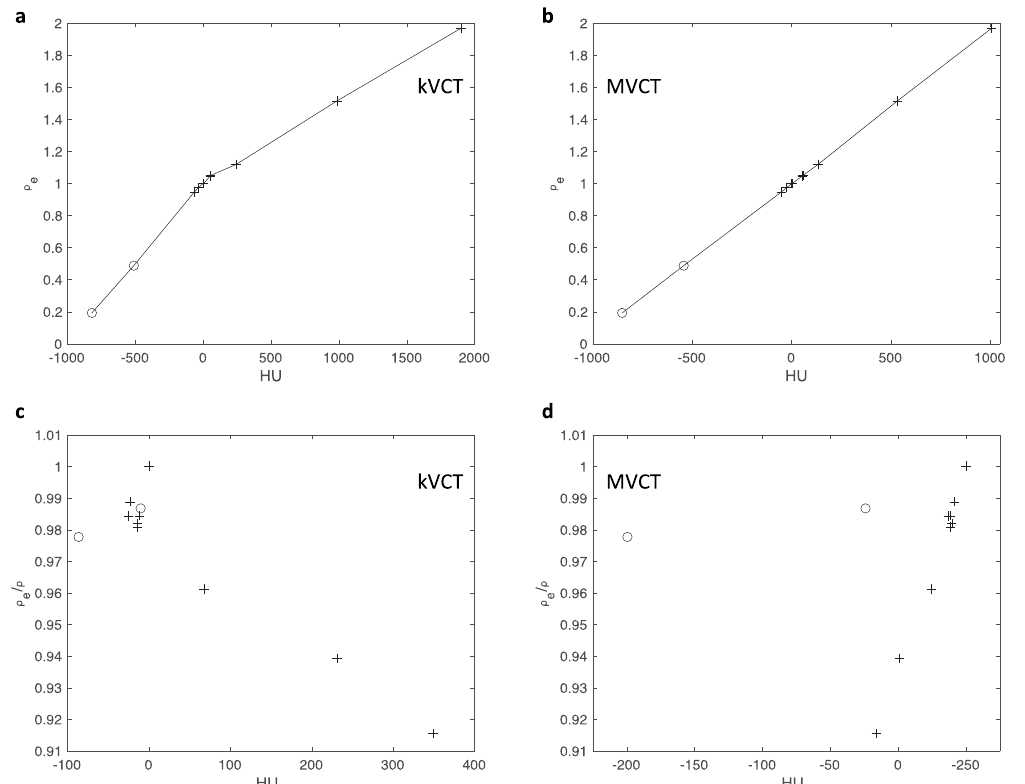
Fig 3. HU plotted against ρ e . For (A) kVCT, (B) MVCT, and HU ρ plotted against ρ e / ρ for (C) kVCT, (D) MVCT for a CIRS tissue surrogate phantom with various tissue mimicking materials and liquid water. Circles (o) represent lung mimicking materials while plus signs (+) represent other tissue mimicking materials (including synthetic soft tissue, liquid water, and synthetic